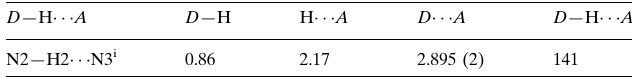
Hydrogen-bond geometry (A˚ , (cid:1)